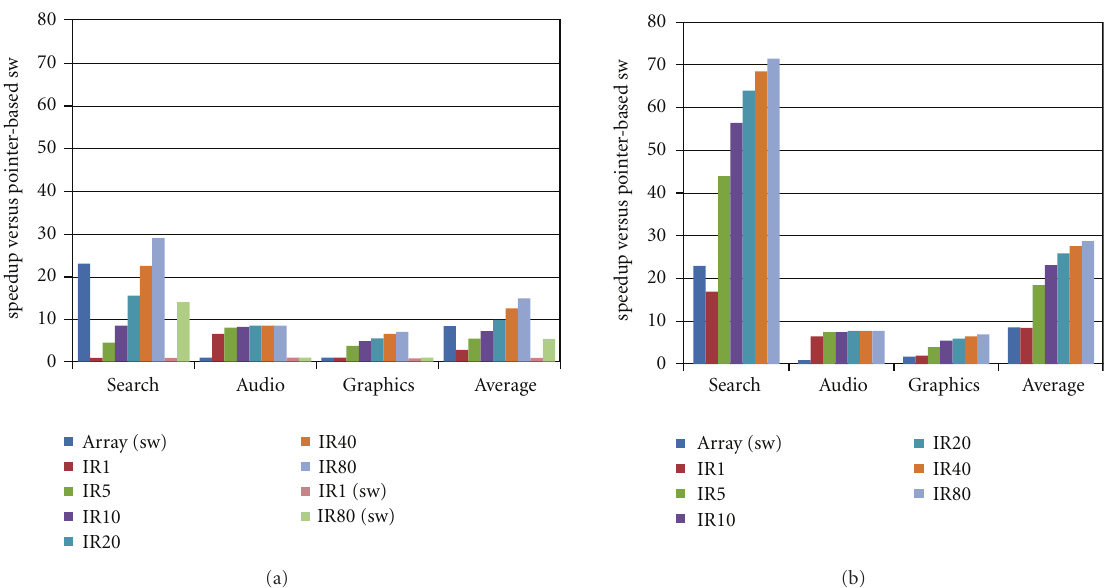
Figure 6: (a) Speedups versus the original pointer-based software implementation obtained for: array-based software (array) and an accelerator using the traversal cache framework for invalidation rates ranging from 1 to 80 (IR1-80). The results show that for some algorithms even high invalidation rates can achieve large speedup. (b) The same comparisons against pointer-based software after recoding the traversal cache implementations to use arrays. A similar speedup for audio and graphics shows that traversal caches can sometimes nearly completely hide the overhead of pointer-based